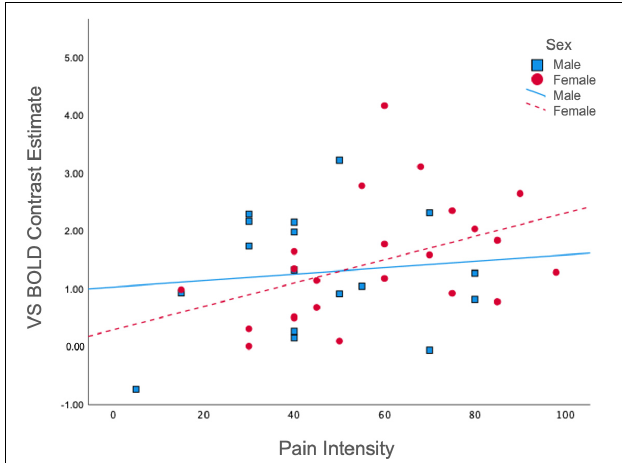
FIGURE 3 | Correlations between pain intensity and ventral striatal responses during reward. Ventral Striatal BOLD during reward anticipation collapsed across all magnitudes was differentially correlated with McGill Pain Intensity scores among males ( r = 0.12, p = 0.66) and females ( r = 0.43, p = 0.04). VS, ventral